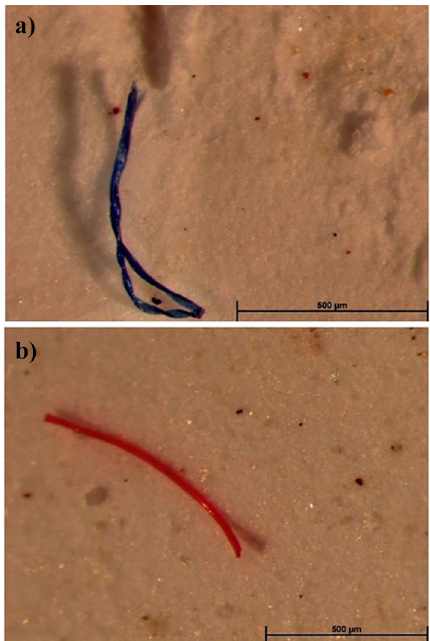
Figure 5. Optical micrographs at different magnification of two microfibers detected on filter surface: ( a ) twisting and convolutions features of a natural microfiber and ( b ) cylindrical shape and smooth surface of a synthetic